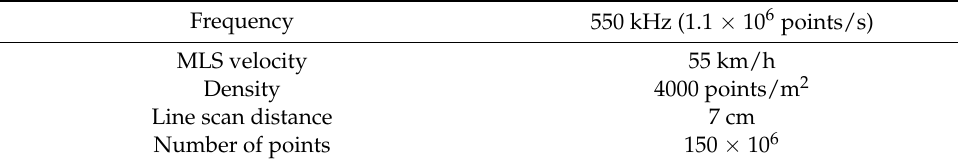
Table 1. Main MLS data